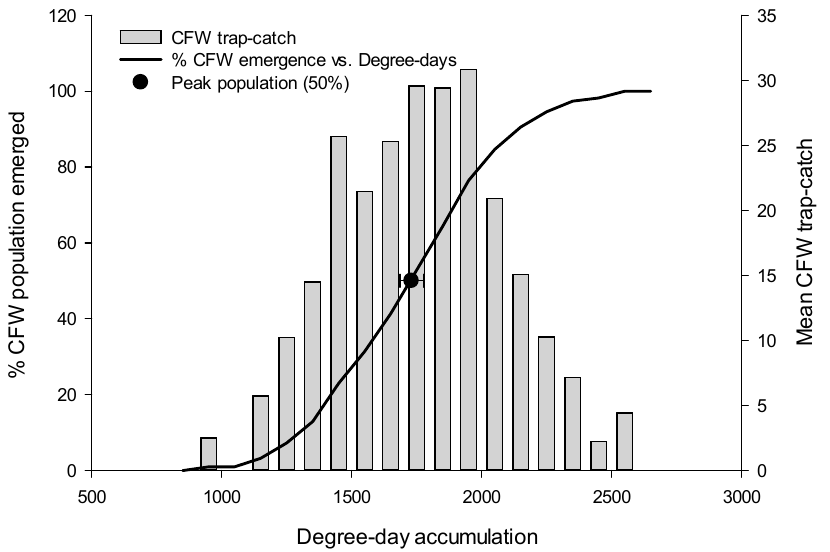
Figure 5. Cranberry fruitworm (CFW) flight (% emergence, trap-catch, and peak flight) plotted as a function of degree-day accumulation. The peak flight interval (the halfway point, indicated by the black circle, ±95% CI) represents the range of degree-days within which peak flight is likely to occur.